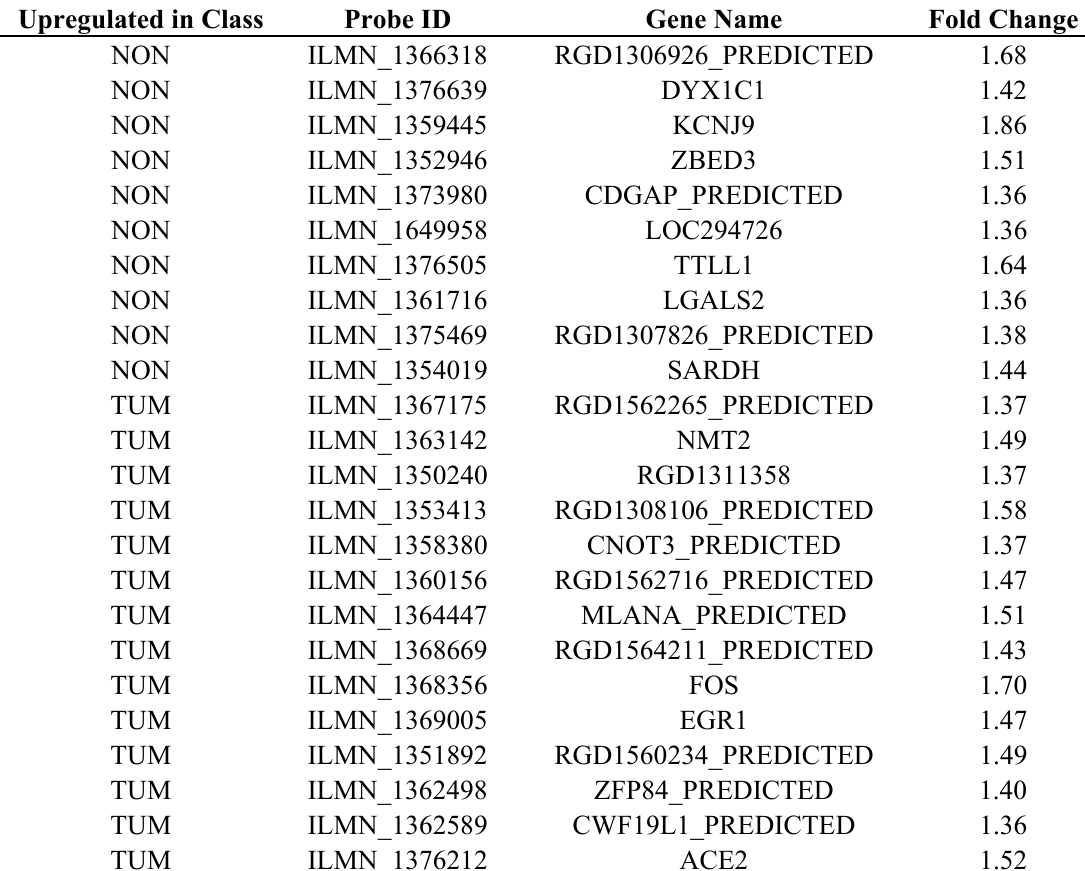
Table 4. Results of CMS analysis between Non-tumor class (NON) and Tumor class (TUM), showing those genes which showed a > 1.50 fold change between the two groups.